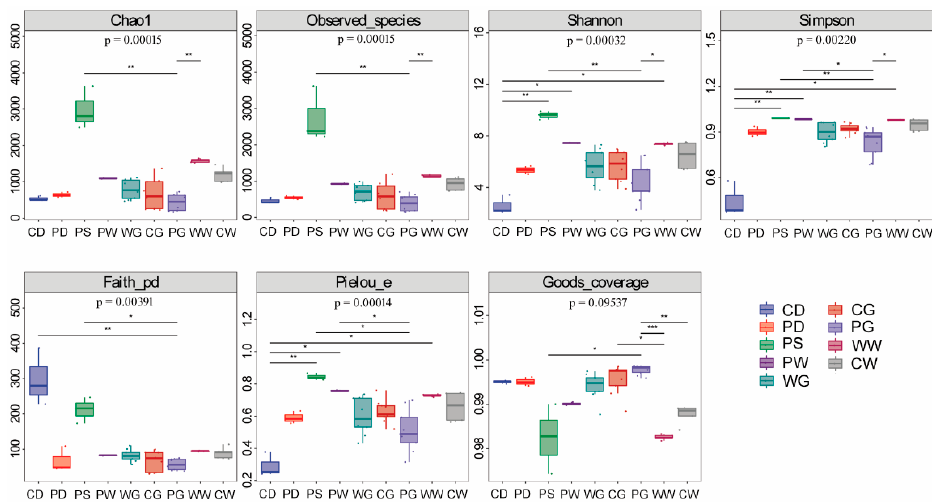
Figure 1. Alpha diversity of the microbiota associated with fish gut, diet, and environmental compartments. Boxplots of microbial community from different groups are outlined in different color; boxes cover the interquartile range (IQR) and the line inside the box denotes the median. Whiskers represent the lowest and highest values within 1.5 × IQR. CD, diet for cage-cultured fish; CG, gut of cage-cultured fish; CW, water from cage culture area; PD, diet for pond-cultured fish; PG, gut of pond-cultured fish; PS, sediment from pond; PW, water from pond; WG, gut of wild-caught fish; WW, water from natural sea area. Asterisk indicated significant difference between two groups, among them, * indicates p < 0.05, **, indicates p < 0.01, ***, indicates p < 0.001.